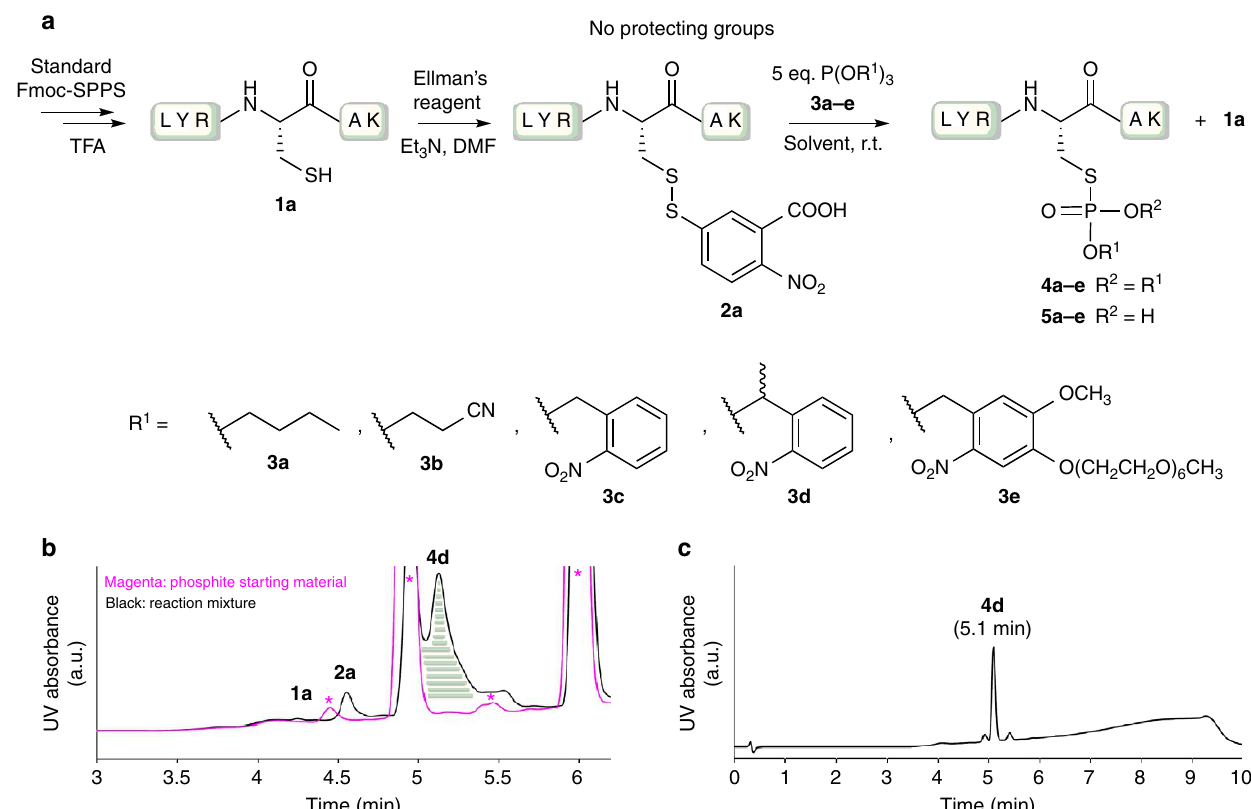
Figure 2 | Chemoselective synthesis of phosphorothiolate esters peptides 4 and 5. ( a ) Reaction of peptide 1a with Ellman’s reagent and peptide 2a with 5eq. phosphite esters 3a – e. ( b ) Overlap of UPLC traces of reaction mixture for peptide 2a and phosphite 3d after 16h (black) and phosphite 3d starting material (magenta). Formation of the phosphorothiolate ester 4d after 16h incubation with phosphite 3d in DMF at room temperature. Magenta asterisk shows the by-products of the phosphite 3d decomposition, which overlap with the reaction mixture UPLC trace for peptide 2a and phosphite 3d . ( c ) UPLC-UV trace after purification by semi-preparative HPLC of phosphorothiolate ester 4d. a.u., arbitrary unit; r.t., room temperature.